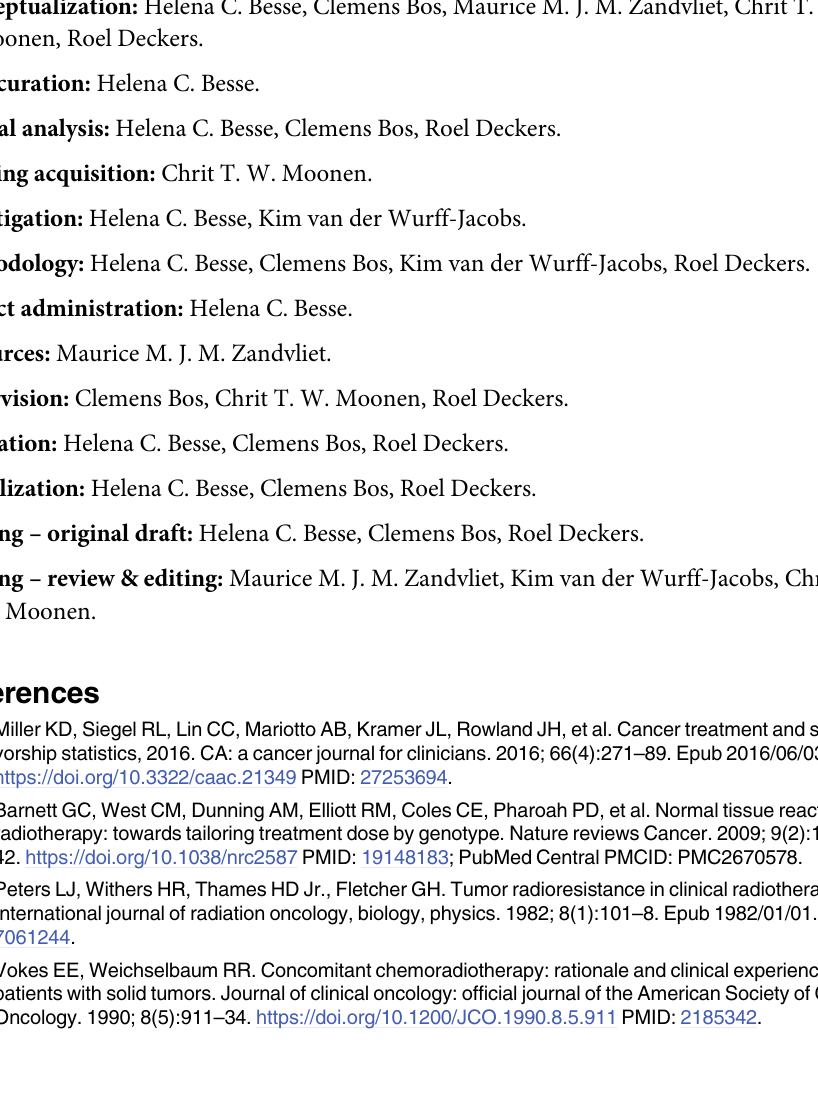
S4 Fig. Survival fraction as function of incubation time of at different temperatures. Cells exposed for 0 to 240 minutes to temperatures ranging between 41 and